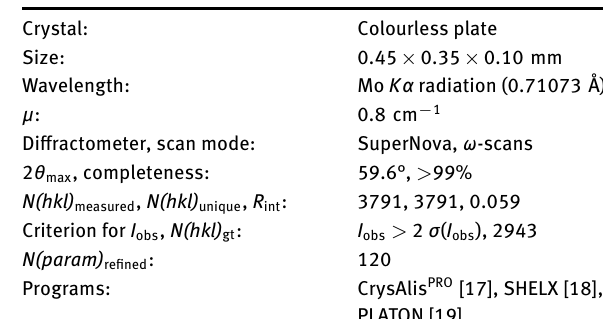
Table 1: Data collection and handling.